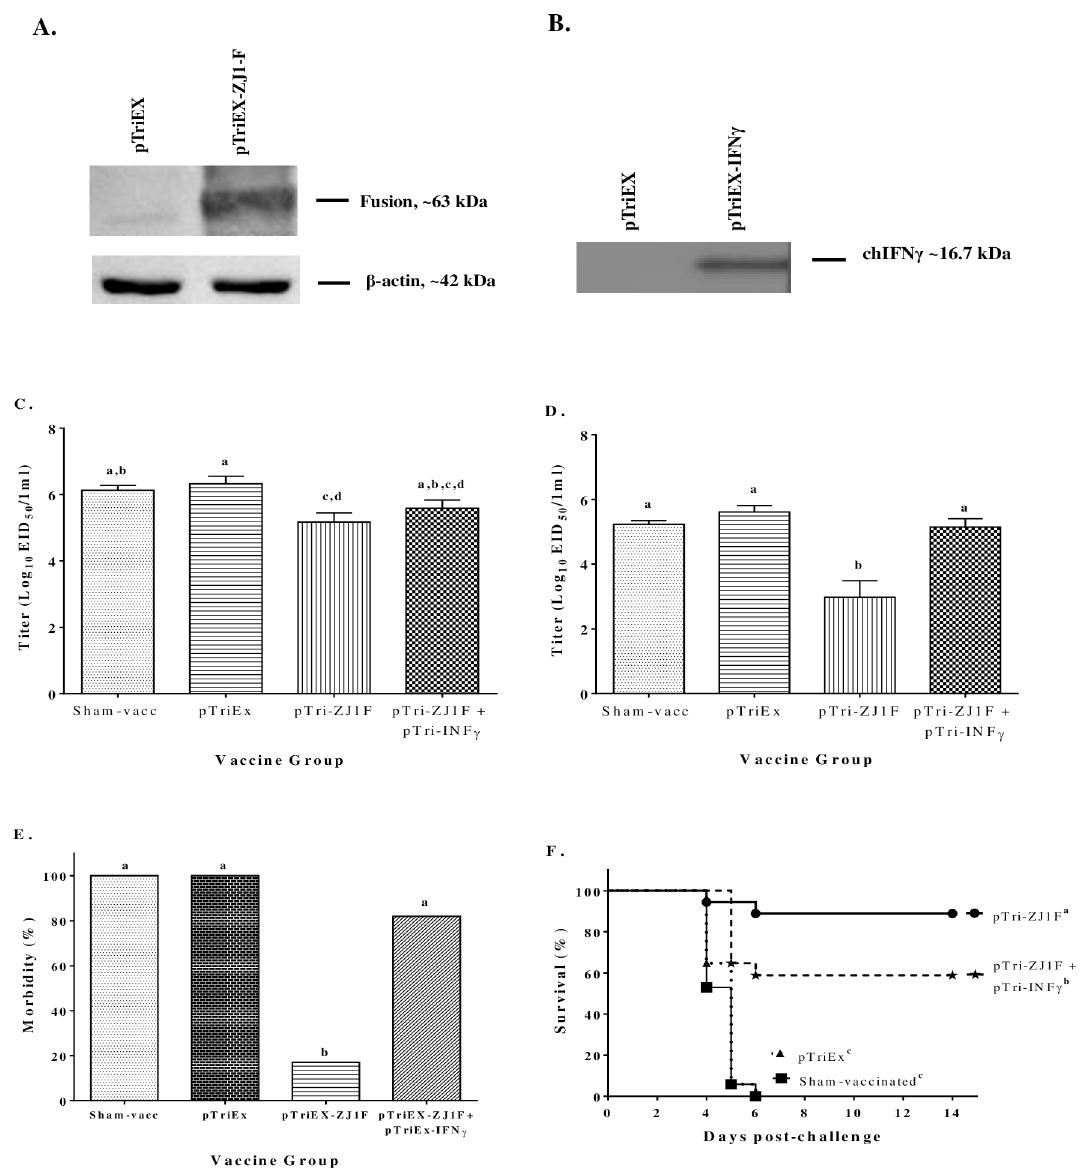
Fig 1. Characterization and evaluation of the effect of co-delivering chIFN γ with a DNA vaccination system. Plasmids expressing NDV F and chIFN γ genes were developed and characterized for their use as DNA vaccines and adjuvant, respectively. DF-1 cells were transfected with pTriEX, pTriEX-ZJ1-F and pTriEX- IFN γ . Cell culture supernatants were tested by western blotting for the presence of F protein (A) and chIFN γ (B) , respectively. Eighteen-day-old SPF ECEs were inoculated with TE buffer, pTriEX, pTriEX-ZJ1-F, or pTriEX-ZJ1-F plus pTriEX- IFN γ and boosted 2 weeks after hatched. Two weeks after booster vaccination, birds were challenged with vZJ1. Oropharyngeal (C) and cloacal (D) swab samples were collected 3 days after challenge to measure the amount of challenge virus shed into the environment. Viral titers were determined by quantitative real time reverse transcription polymerase chain reaction (qRRT-PCR). A standard was prepared with a vZJ1 virus stock of know concentration, this was included in every plate and was used to obtain viral titers expressed as EID 50 /mL. Morbidity (E) and mortality (F) were also evaluated. Viral shedding results were analyzed with One-way ANOVA followed by a multiple comparisons Tukey's test. Differences in morbidity among groups were evaluated using a two-tailed Z test for comparison of sample proportions. Survival curves were analyzed using the Long-Rank test. Statistical difference was considered with a P < 0 . 05 . Significant differences are denoted by different